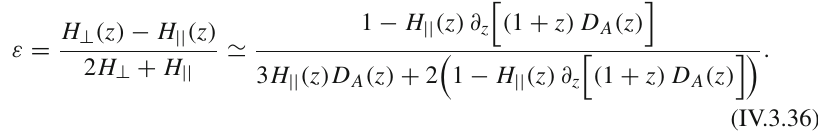
that can be reached with an experiment like Euclid is extremely high; we can measure the curvature parameter better than 0.02 at redshift of z (cid:7) 1. This will allow us to discriminate between FLRW and averaged cosmology as for example illustrated in Fig.